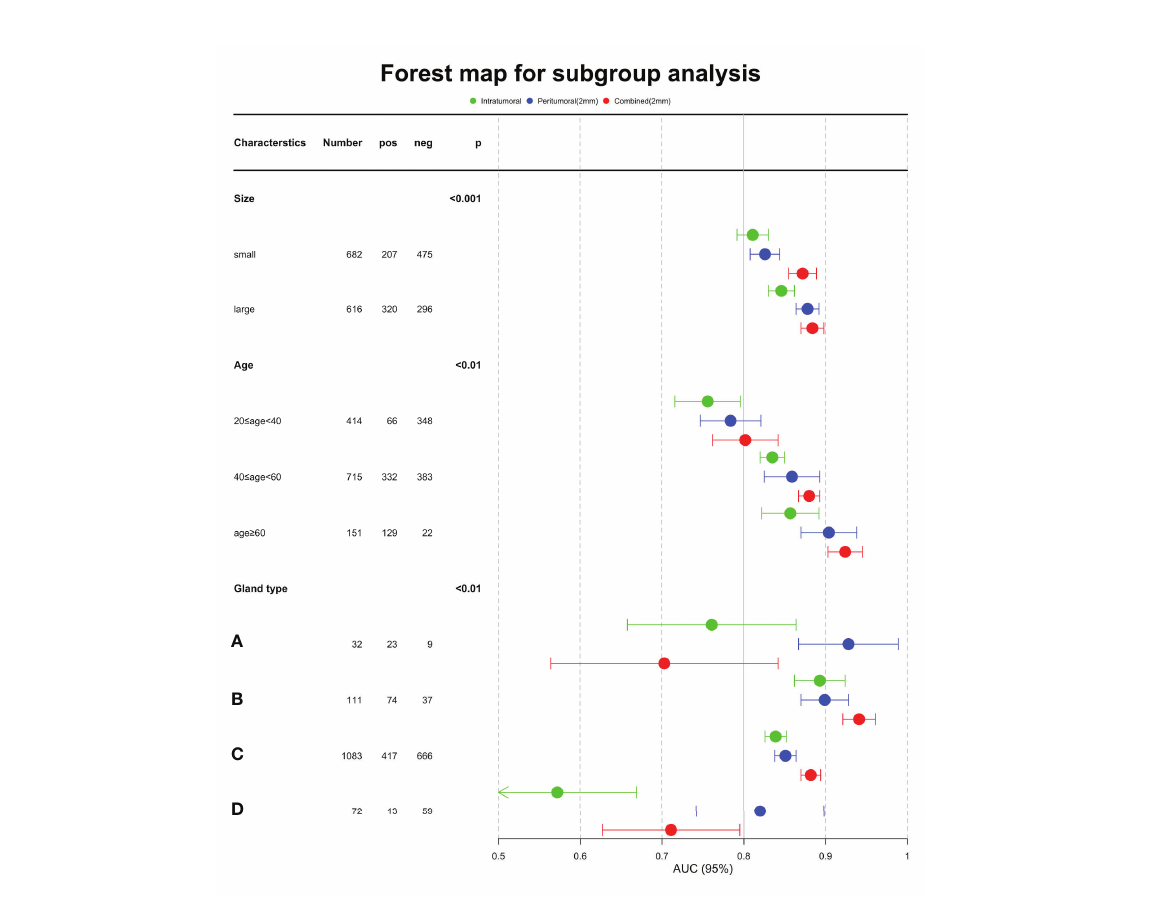
FIGURE 6 Forest map displayed the AUC of the three models in subgroup